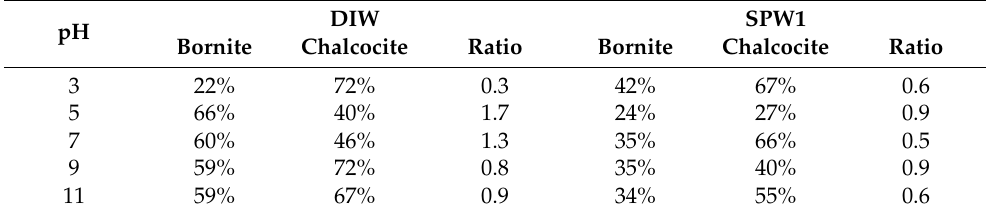
Figure 3. Final mass recovery of bornite and chalcocite at different pH levels . Table 3. Ratio of the recovery of bornite to chalcocite .